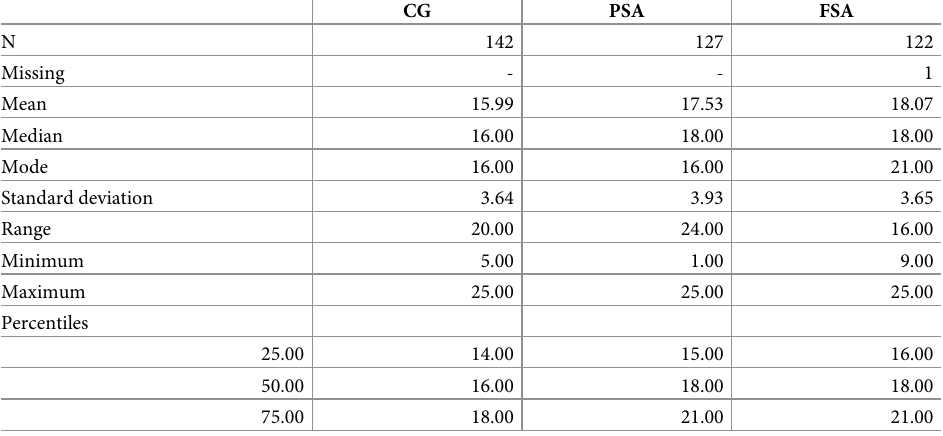
Table 6. Descriptive analysis of the results of the participants’ subjective assessment of the different waiting room